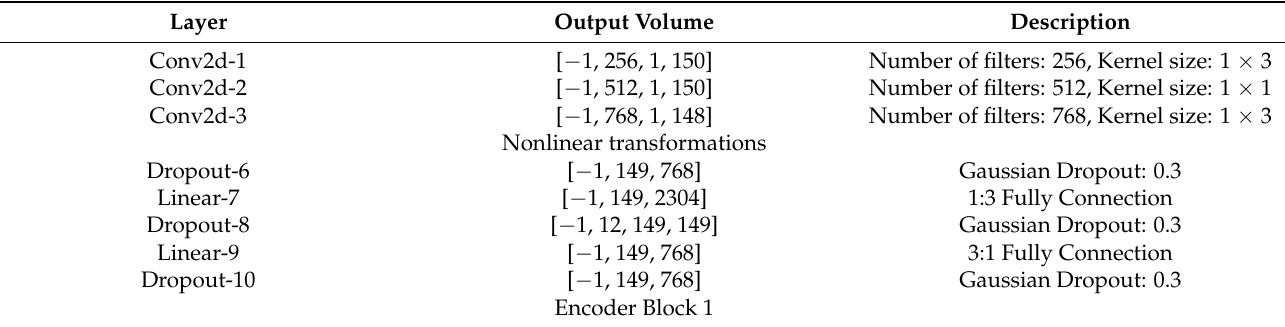
Figure 1. Overall structure of the PCViT model. Table 1. Model structure.